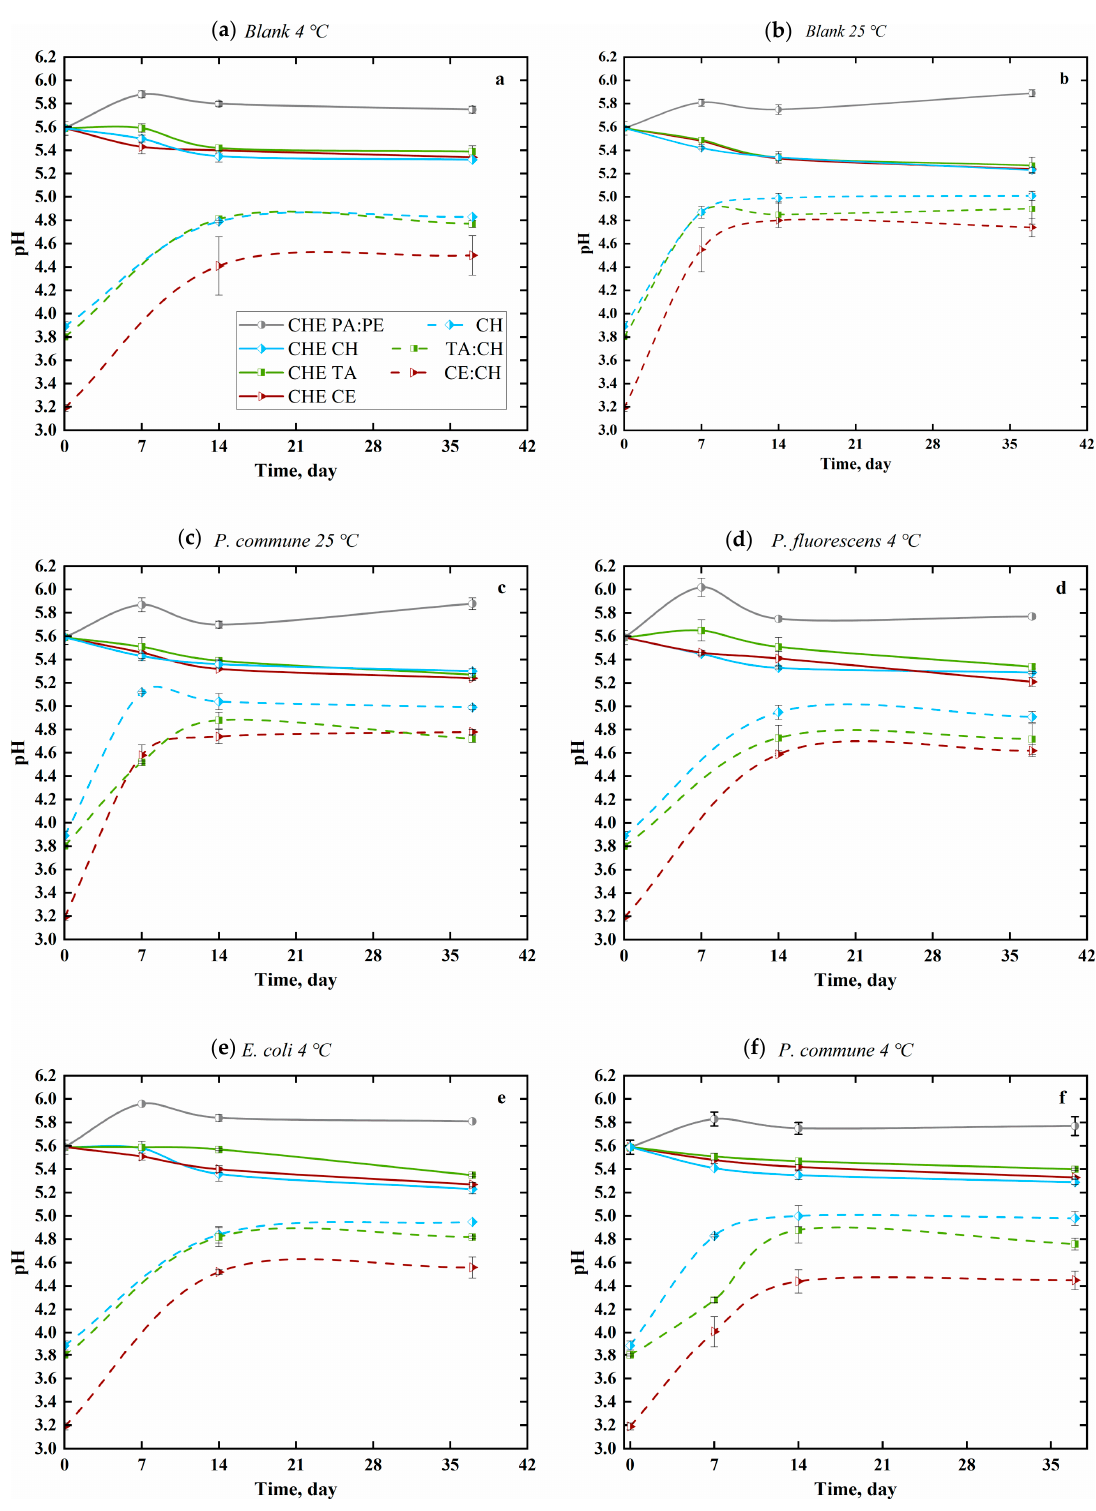
Figure 4. effect of biopolymer films (CH, TA:CH, CE:CH) on pH in cheese, compared to simultaneous pH change in films (2 × 2 cm) at 4 °C in ( a ) Blank (non-inoculated), ( d ) P. fluorescens ( e ) E. coli , ( f ) P. commune and at 25 °C in ( b ) Blank (non-inoculated), ( c ) P. commune sample sets. Dashed lines represent packaging material results. Values are means ( n = 2 × 1) with standard errors that are significantly different within columns ( p < 0.05; Table S3).